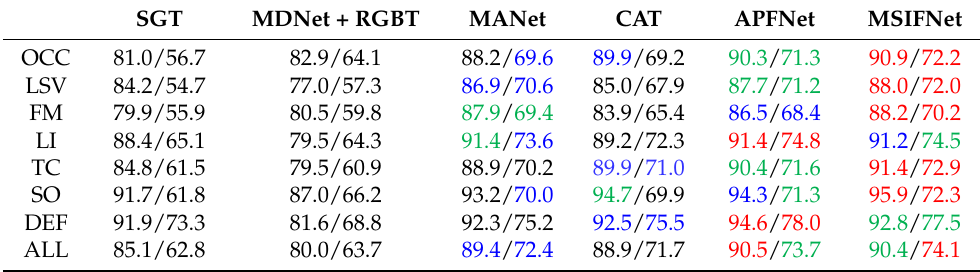
Table 1. Attribute-based PR/SR scores (%) on the GTOT